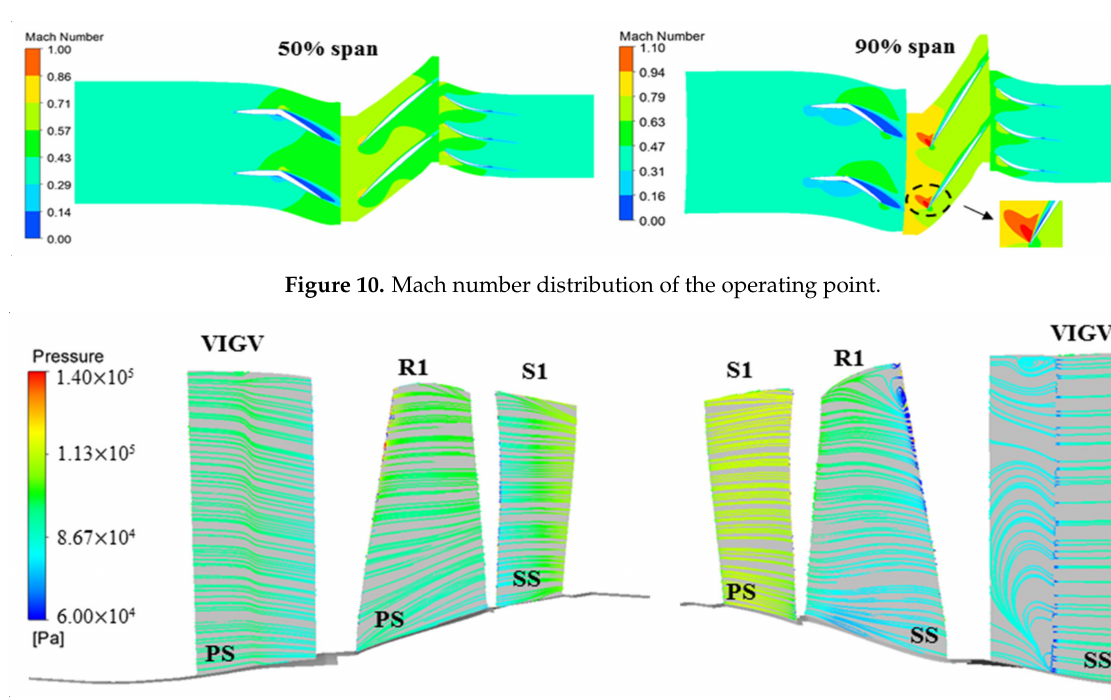
Figure 11. Streamline and pressure distribution of the operating